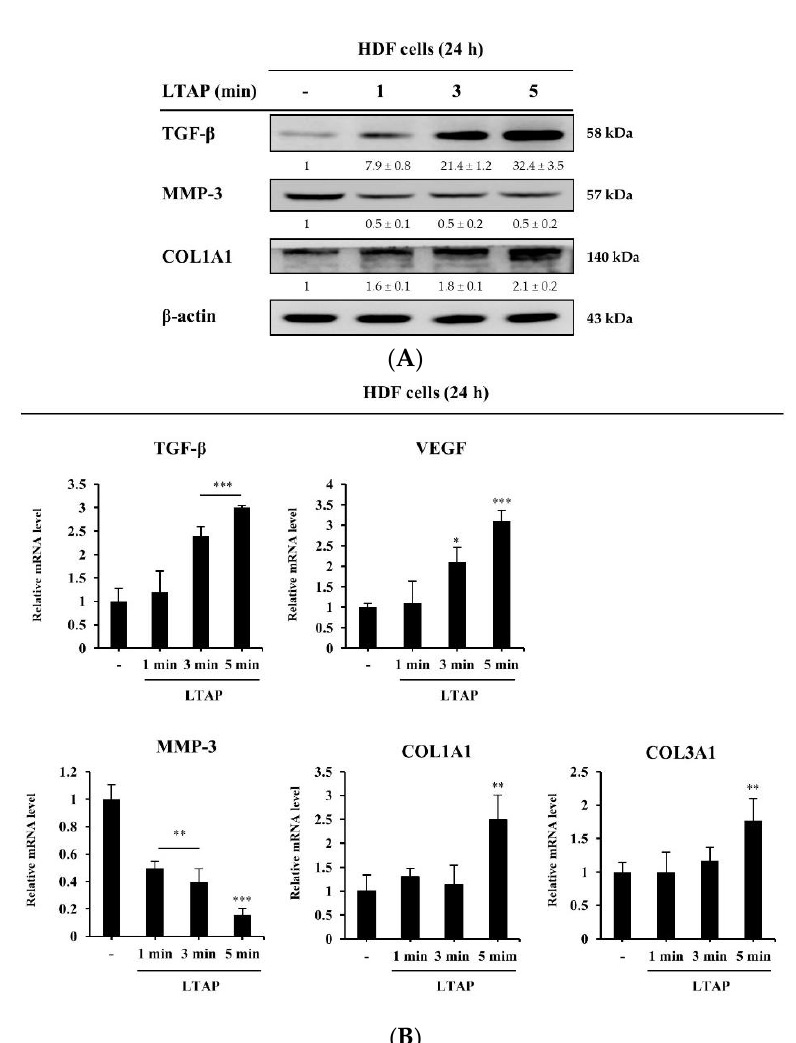
Figure 2. LTAP regulates proliferating and aging factors in human dermal fibroblasts (HDFs). HDFs were exposed to LTAP for 1, 3, or 5 min, and further incubated for 24 h. ( A ) Expression levels of transforming growth factor- β (TGF - β), matrix metallopeptidase -3 (MMP-3), and collagen type I alpha 1 (COL1A1) were analyzed by Western blotting. β -actin was used as a loading control. Numeri- cal values on the blots represent DU. The control was normalized to 1 DU. All data represent three independent experiments. ( B ) mRNA expression analysis for TGF- β , vascular endothelial growth factor ( VEGF ), MMP-3 , COL1A1 , and COL3A1 was performed by qRT-PCR. Data represent three independent experiments and are the means ± SD. * p < 0.05, ** p < 0.01, *** p < 0.001 (control vs. LTAP-exposed cells).